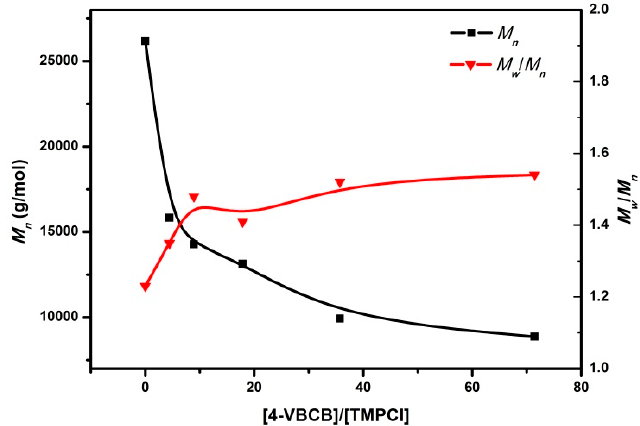
Figure 3. Mn and Mw / Mn values of poly(IB- co -4-VBCB) in different feed ratios of 4-VBCB to TMPCl initiated by TMPCl/DTBP/TiCl 4 system in cyclohexane/CH 3 Cl (60/40 v/v ) at − 80 °C, [IB] = 1.01 M, [TMPCl] = 1.41 × 10 − 3 M , [DTBP] = 3.53 × 10 − 3 M , and [TiCl 4 ] = 4.52 × 10 − 2 M.